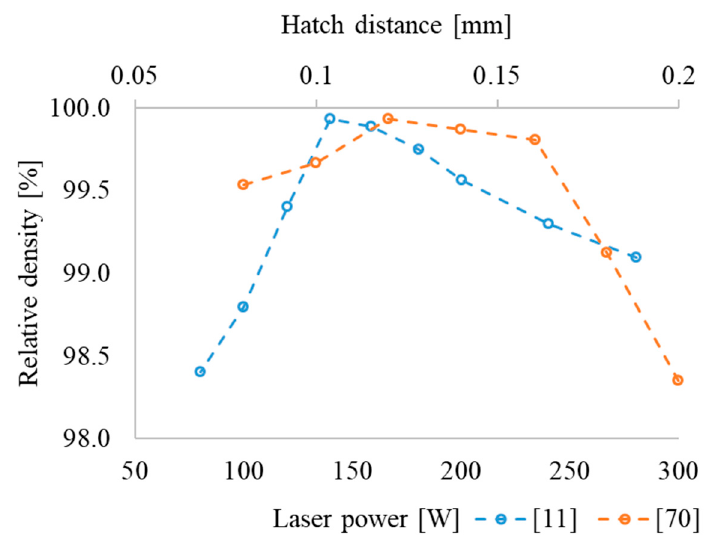
Figure 7. Effect of the laser energy (P) and hatch distance (HD) on the density of the O-phase-based alloy produced by L-PBF based on the data from [11,70].